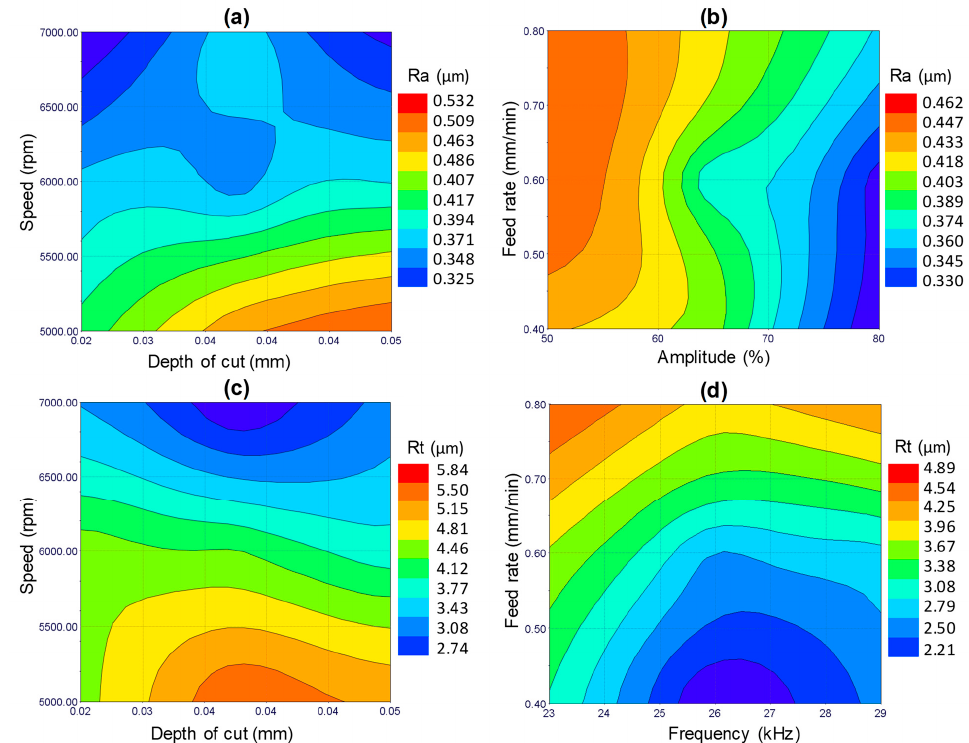
Figure 10. Response surface plots, i.e., effects of the indicated process parameters on ( a ) and ( b ) Ra, and ( c ) and ( d ) Rt .